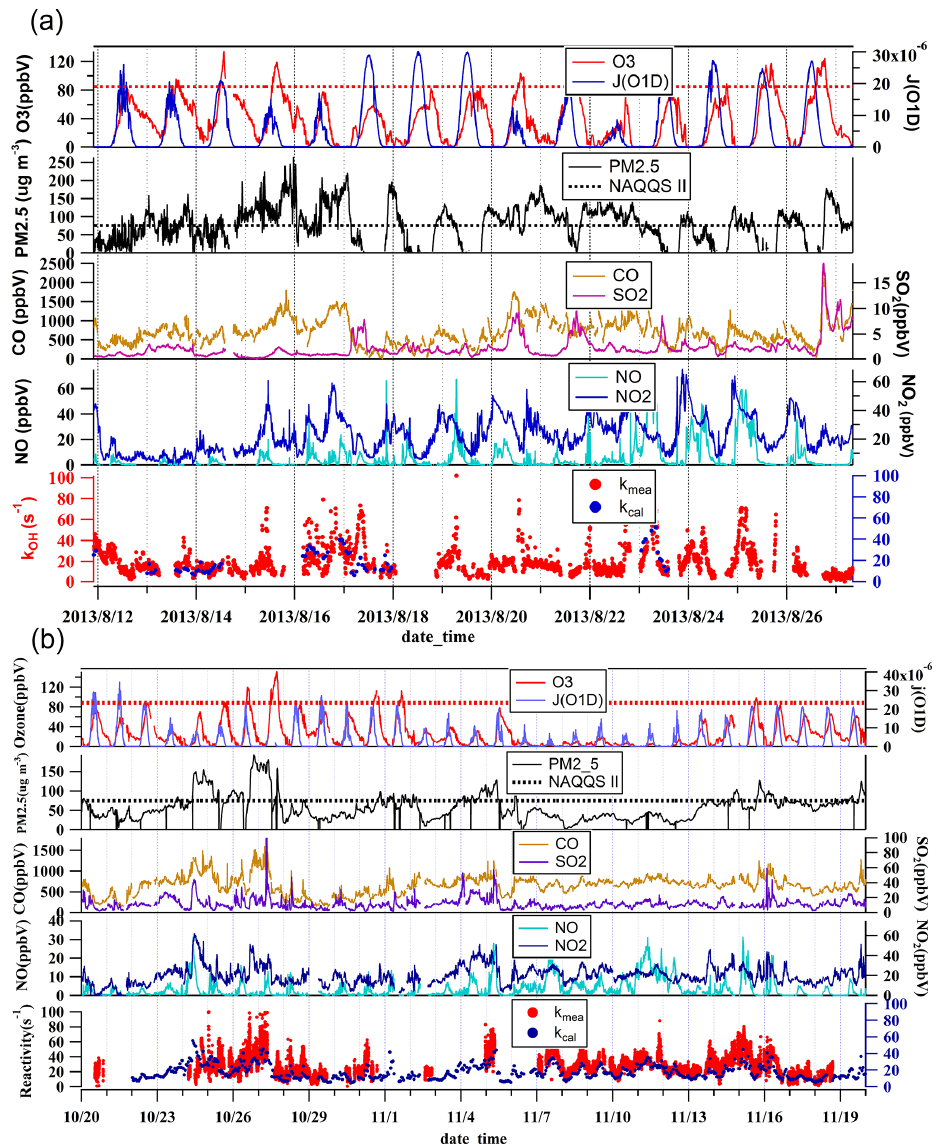
Figure 5. (a) Time series of meteorological parameters and inorganic trace gases during August 2013 in Beijing. Red and black dashed lines are Grade II of the National Ambient Air Quality Standard. (b) Time series of meteorological parameters and inorganic trace gases during October–November 2014 in Heshan. Red and black dashed lines are Grade II of the National Ambient Air Quality